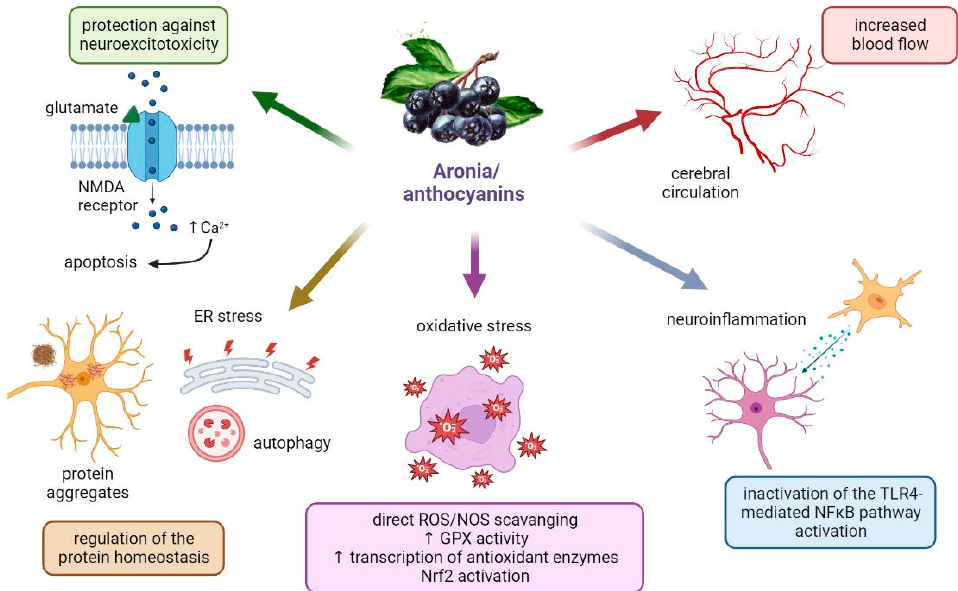
Figure 4. Proposed mechanisms by which Aronia melanocarpa berry and its major components, anthocyanins, exert neuroprotective effects. It is thought to involve multiple processes, including antioxidant activity, anti-inflammatory effects, reduction in protein aggregation, increased blood flow to the brain, and protection against neuroexcitotoxicity. Abbreviations: NMDA, N-methyl-D-aspartate receptor; ER, endoplasmatic reticulum; GPx, glutathione peroxidase; ROS, reactive oxygen species; NOS, reactive nitrogen species; Nrf2, nuclear factor erythroid 2–related factor 2; TLR4, Toll-like receptor 4; NF κ B, nuclear factor- κ B.